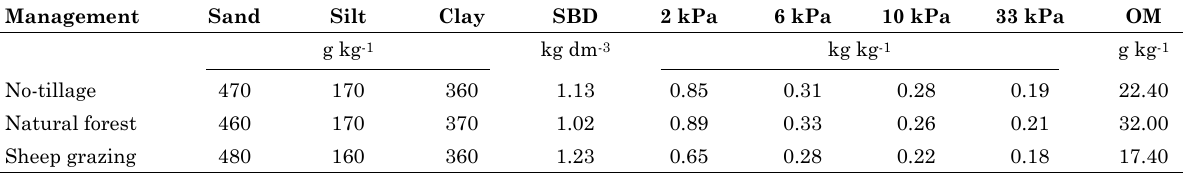
Table 1. Physical properties, moisture content at different tensions and organic matter of Latossolo Vermelho-Amarelo distrófico (Oxisol), under different management systems, in the 0-5 cm layer